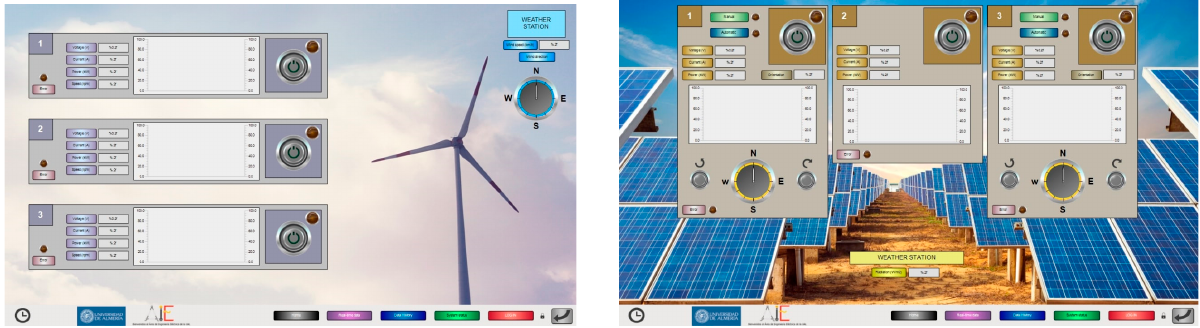
Figure 8. View of the wind ( left ) and pv ( right )